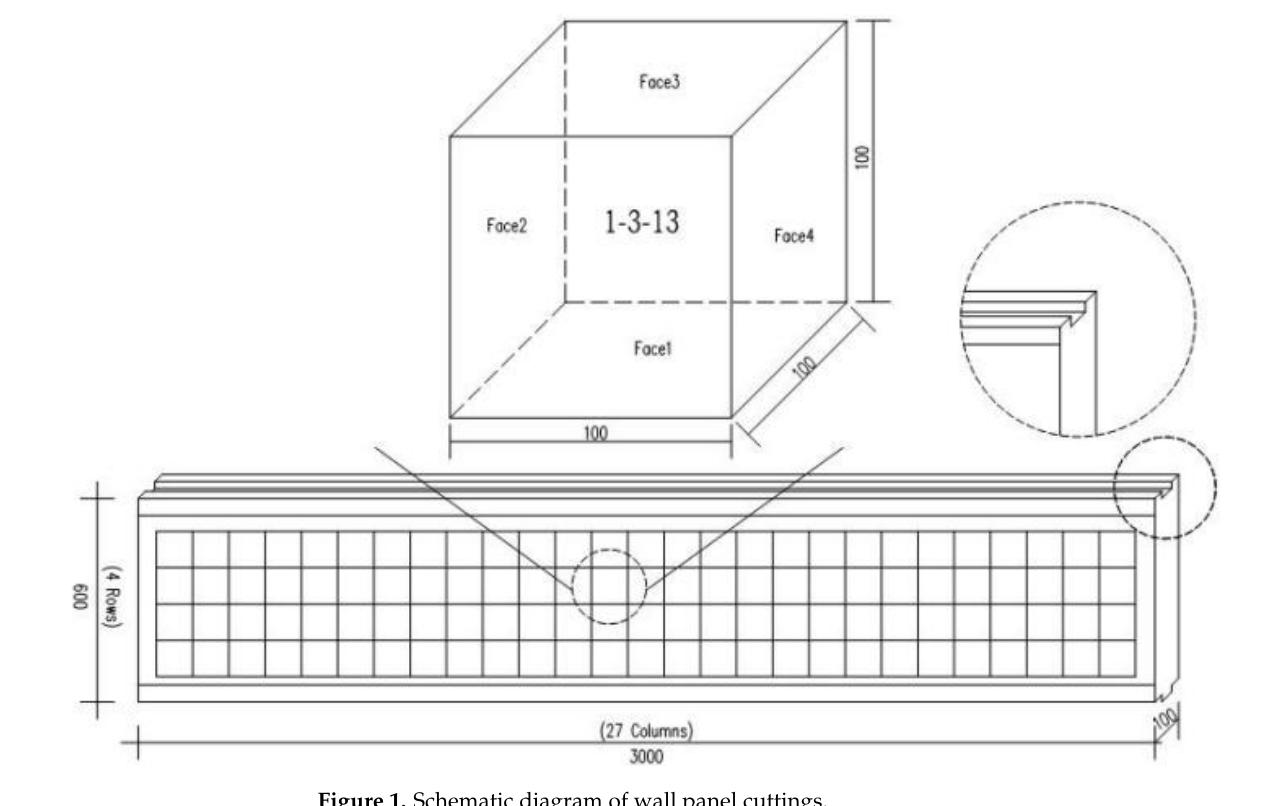
Figure 1. Schematic diagram of wall panel cuttings.